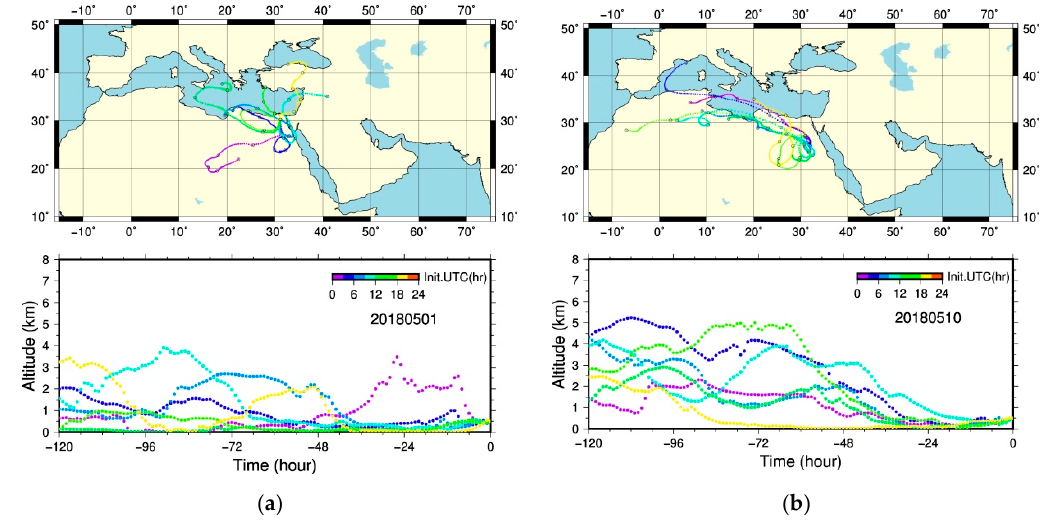
Figure 5. Five-day backward trajectory analyses initialized at ( a ) 30 ◦ 15 (cid:48) N & 31 ◦ 10 (cid:48) E on 1 May 2018, ( b ) 27 ◦ 14 (cid:48) N & 30 ◦ 58 (cid:48) on 10 May 2018. The bottom panel shows the trajectories with time (0–120 h / backward) and altitude (0–500